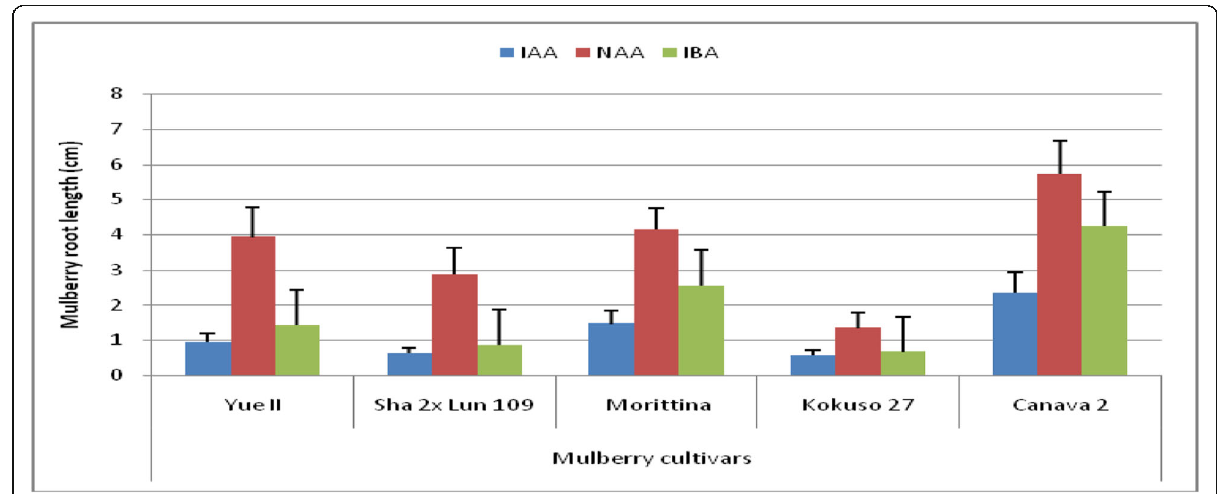
Fig. 5 Effect of MS supplemented with 1 mg/l IAA, NAA, or IBA on the average of rootlet length (cm) of different mulberry cultivars. Cultures were incubated under the rhythm of light/dark condition (16/8 h). Each treatment is the average of 3 replicates ±